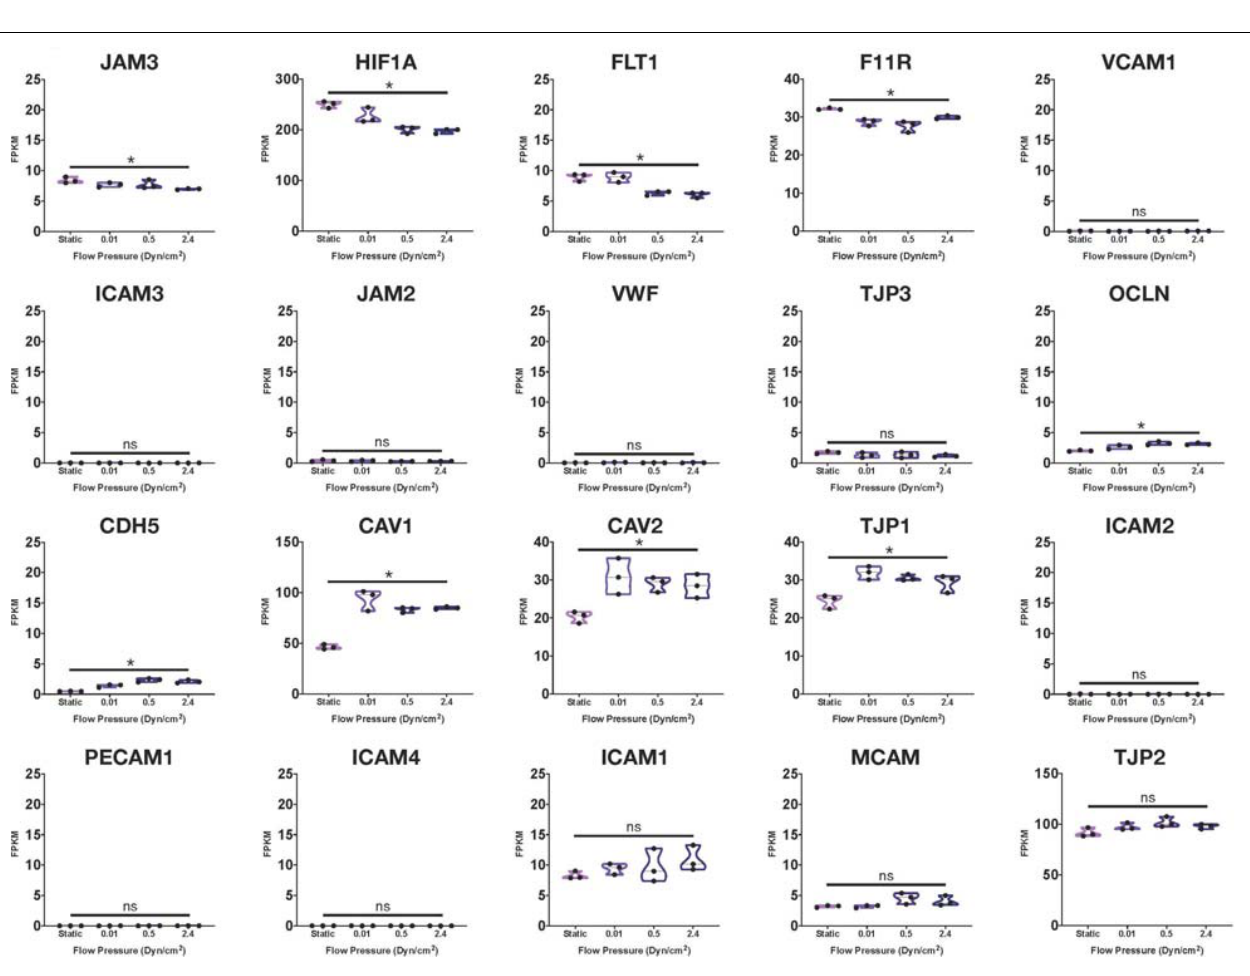
FIGURE 2 | Junctional-related gene RNA expression in iBMECs under sheer stress. Violin plots of junctional-related gene expression in iBMEC organ-chip samples at various flow pressures adapted from data provided by Vatine et al. (2019). Genes were defined as junctional-related according to the referenced study (significance indicates p -value <